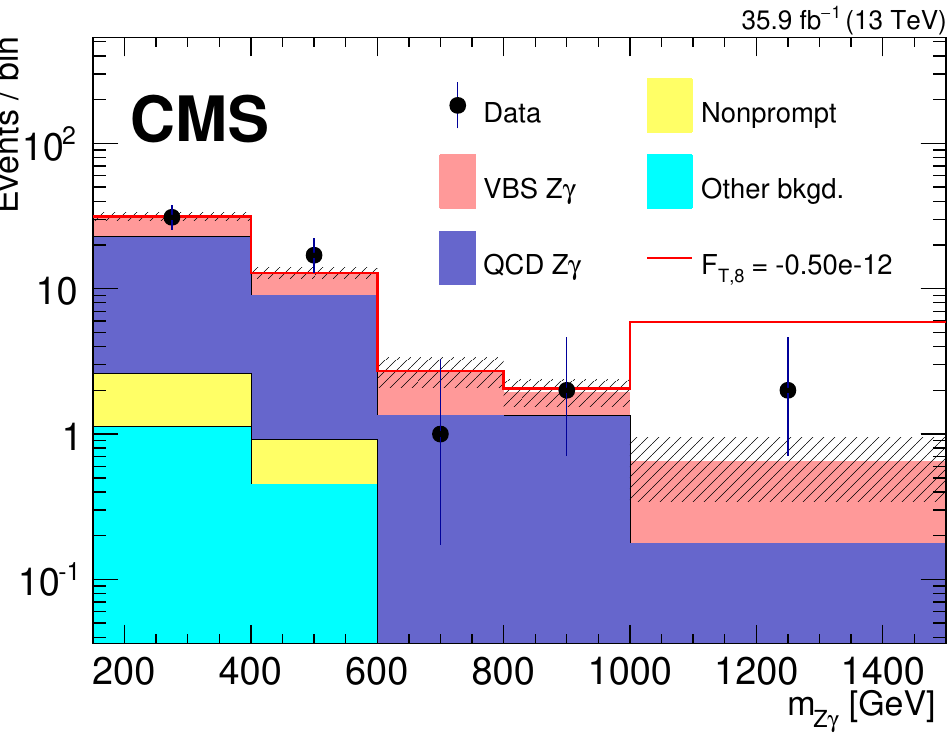
Figure 6 . The m distribution of events satisfying the aQGC region selection, which is used Z (cid:13) to set constraints on the anomalous coupling parameters. The red line represents a nonzero F setting, which would signi(cid:12)cantly enhance the yields at high m 600, 800, 1000, 1500] GeV, where the last bin includes over(cid:13)ow. The hatched bands represent the statistical uncertainties in the